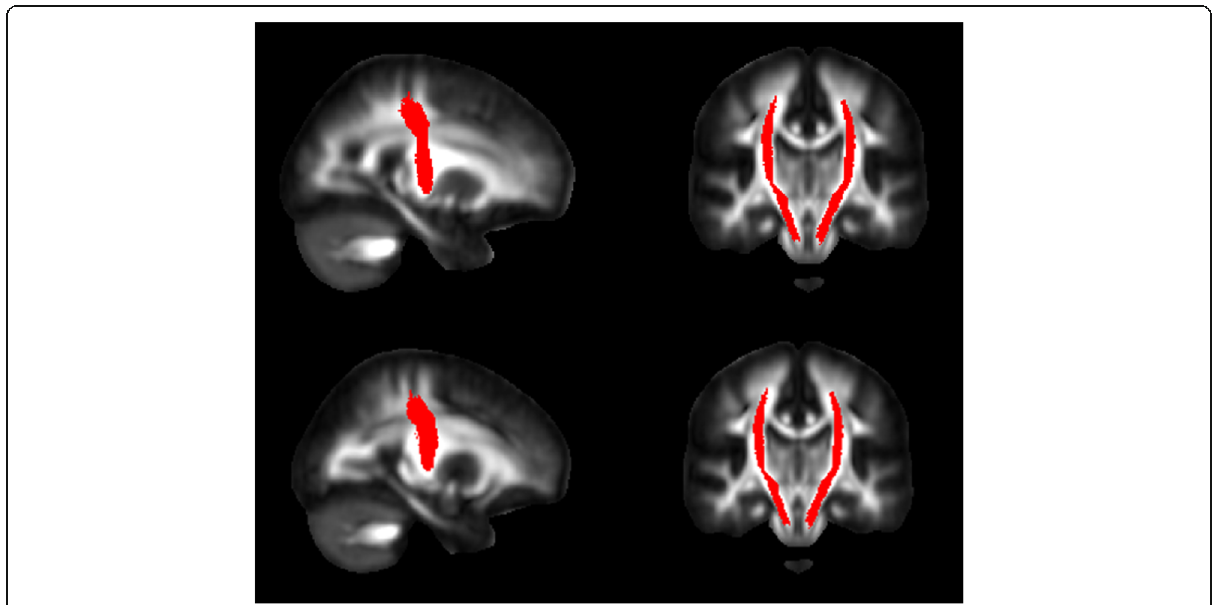
Fig. 1 Bilateral corticospinal tract mask (in red) used as a control region